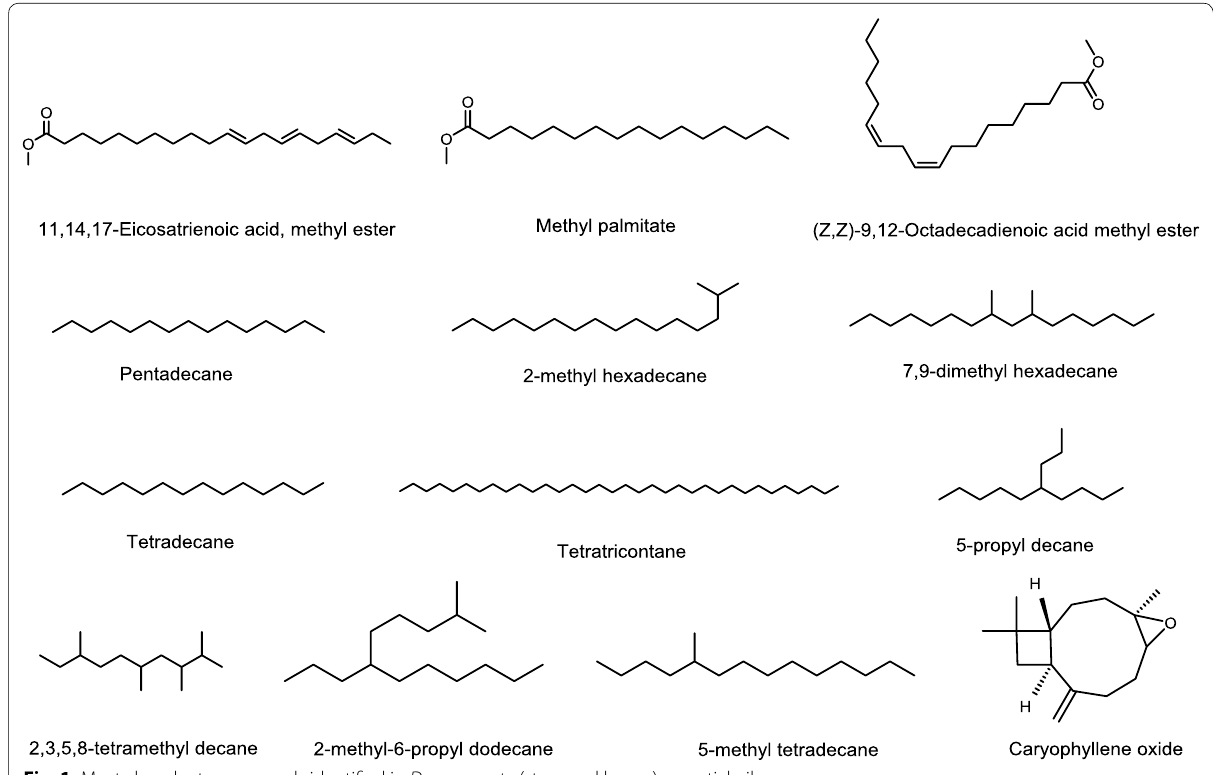
Fig. 1 Most abundant compounds identified in D. mucronata (stem and leaves) essential